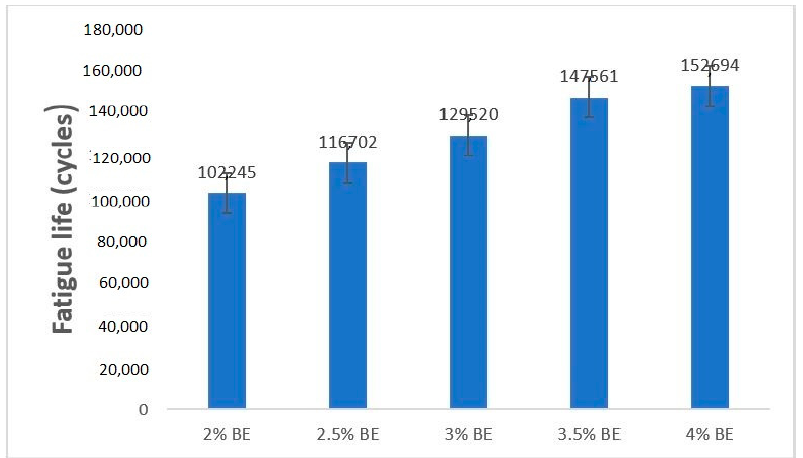
Figure 12. Results of fatigue testing for RAP.